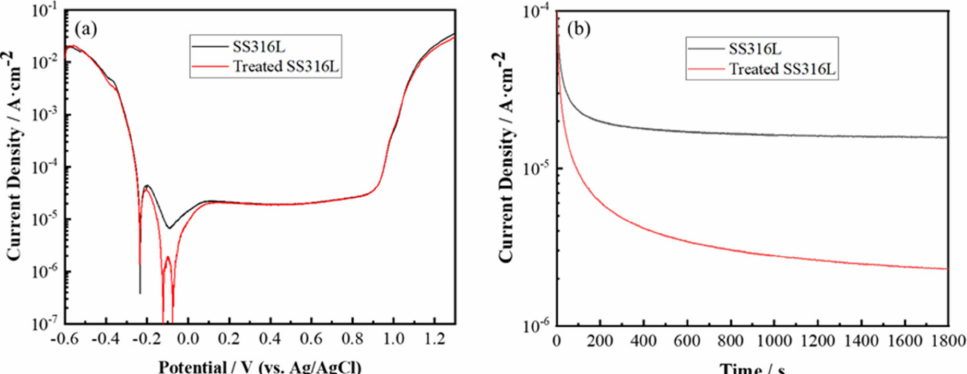
Figure 1. Electrochemical tests for original and treated stainless steel 316L (SS316L). ( a ) potentiody- namic tests in 0.5 M H 2 SO 4 and 2 ppm HF solutions bubbled with argon at 70 ◦ C and ( b ) potentiostatic tests in 0.5 M H 2 SO 4 and 2 ppm HF solutions bubbled with oxygen at 70 ◦ C for 0.5